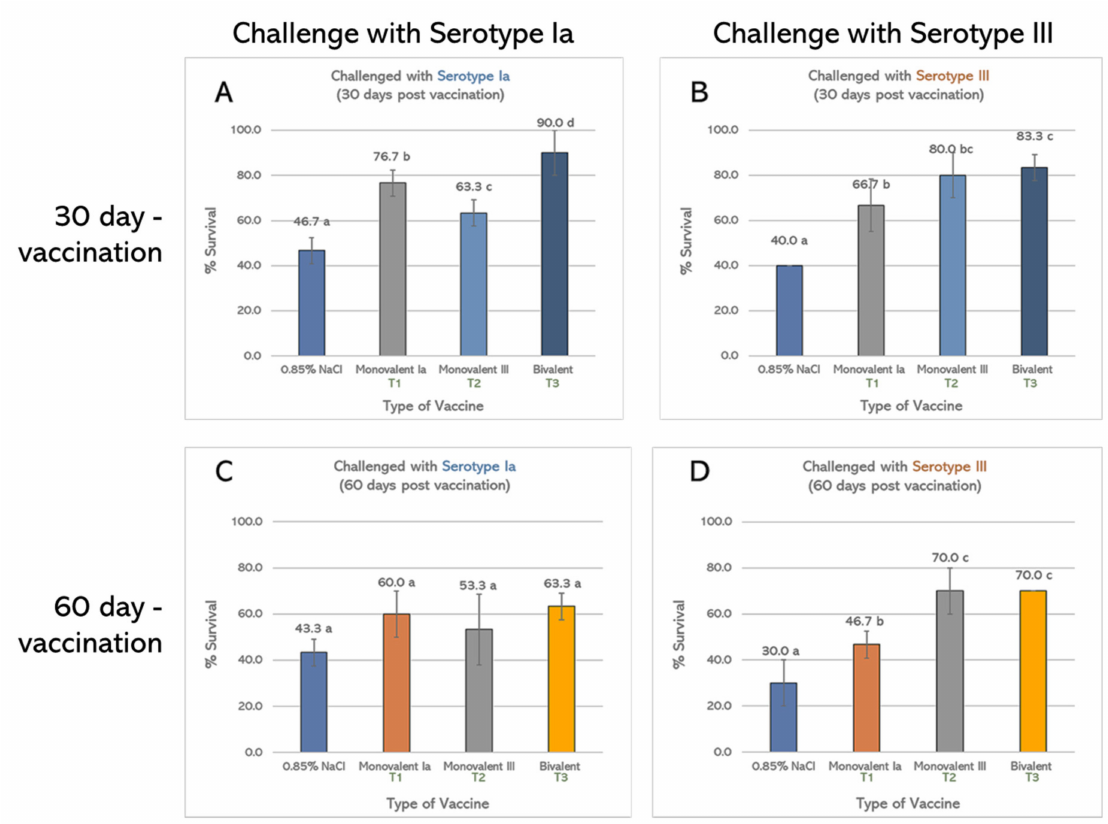
Figure 5. Percent survival of Nile tilapia ( Oreochromis niloticus Linn.) immunized with monovalent vaccine: serotype Ia (T1); monovalent vaccine: serotype III (T2), bivalent vaccine (T3), and non- vaccinated (control). After vaccination at 30 days, fish were challenged with S. agalactiae serotype Ia ( A ) and serotype III ( B ). After vaccination for 60 days, fish were challenged with S. agalactiae serotype Ia ( C ) and serotype III ( D ) ( n = 30). a, b, c, and d = significant difference ( p <